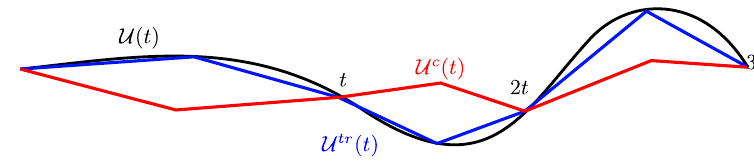
Figure 10: A sketch of the “refocussing” mechanism that potentially explains the structures observed in Fig. 9. Here the targeted time evolution U ( t ) is shown in black, the Trotter evolution U tr ( t ) is shown in blue, and the compressed evolution U c ( t ) is shown in red. While U tr ( t ) follows the target trajectory quite closely, U c ( t ) instead becomes “refocussed” at multiples of the optimization timestep t .